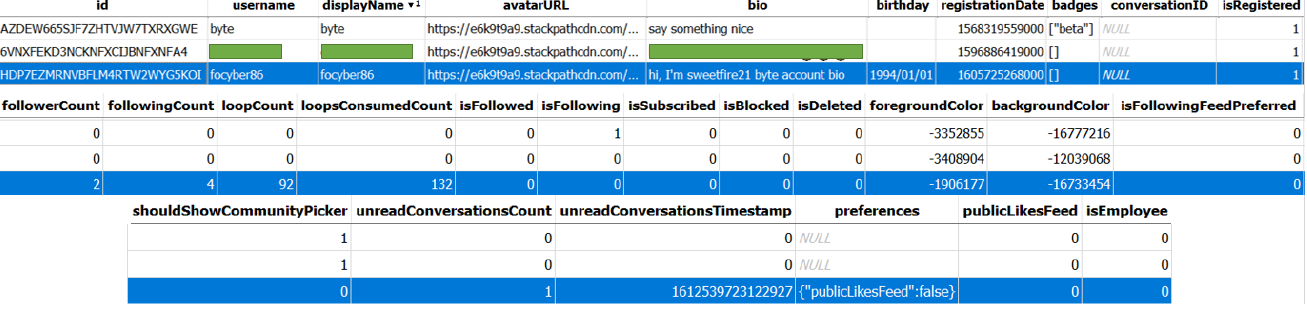
Figure 2. The contents of byte.db\Account from Byte Android investigation demonstrating personal user data (id, birthday, registration date, count of followers, message ID) details as shown in DB Browser for